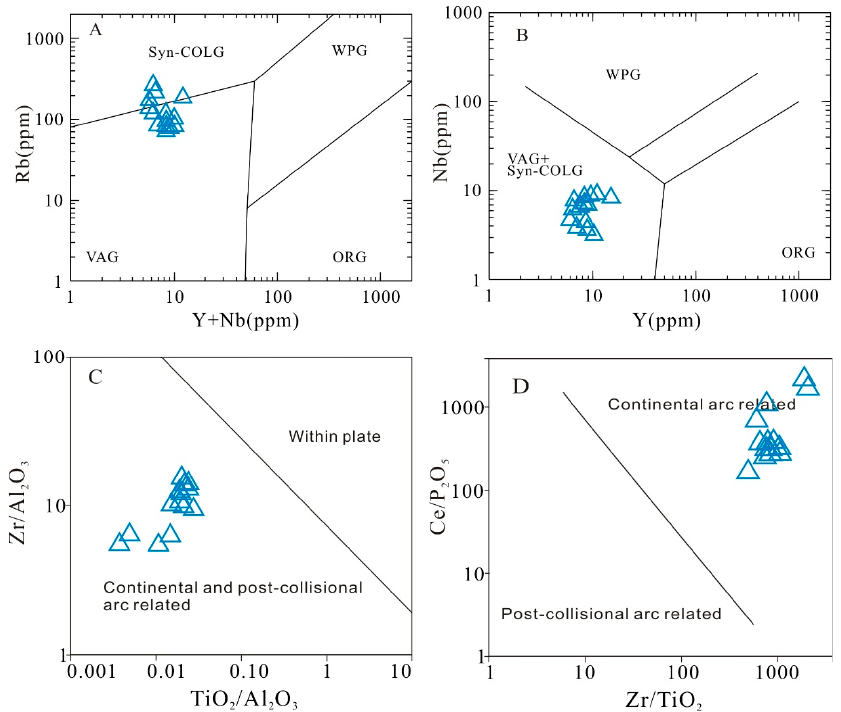
Figure 10. ( A ) Rb– (Y + Nb), ( B ) Nb–Y, ( C ) Zr/Al 2 O 3 —TiO 2 /Al 2 O 3 and ( D ) Ce/P 2 O 5 —Zr/TiO 2 discrimination diagrams of the monzogranite (adapted from Pearce et al., 1984; Muller and Groves, 1994; Pearce, 1996) [78,110,111] . VAG: volcanic arc granites; ORG: ocean ridge granites; WPG: within-plate granites; syn-COLG: syn-collision granites; post-COLG: post-collision granites. The symbols are the same as in Figure 7.